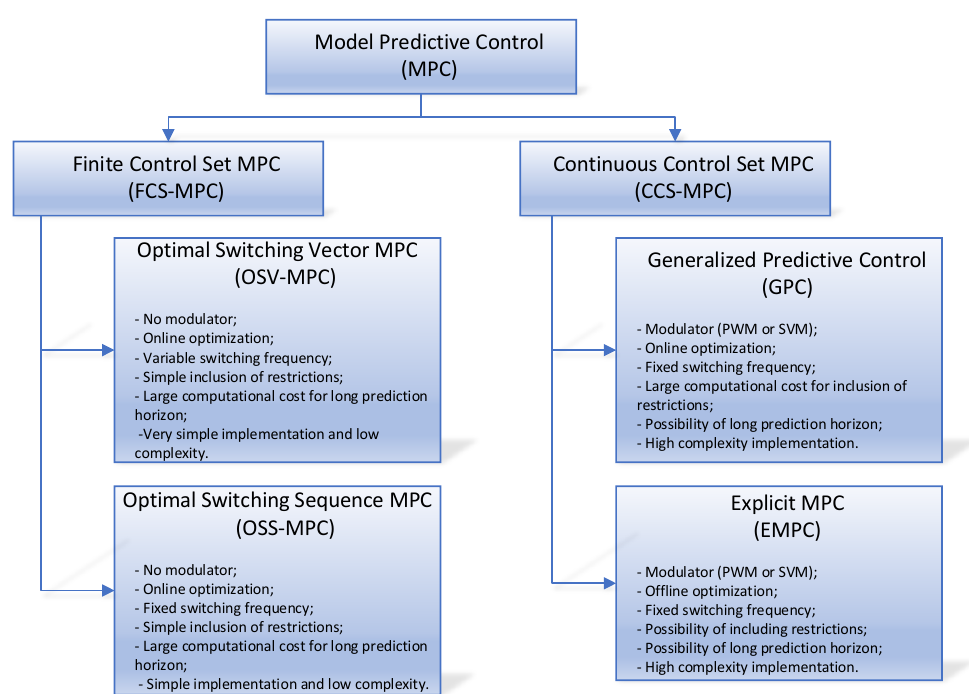
Figure 9. Model predictive control